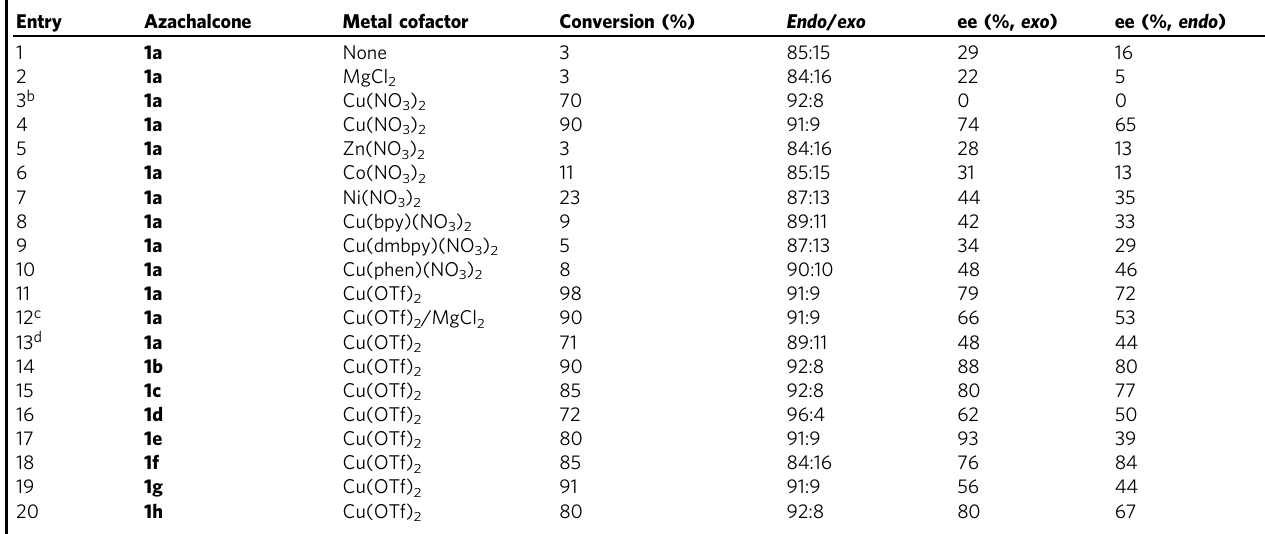
Table 1 Enantioselective Diels – Alder reactions catalysed by metallo – ATP complexes a . Entry